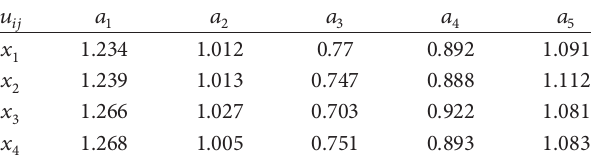
Table 6: Weight vector 𝑢 𝑖𝑗 of each